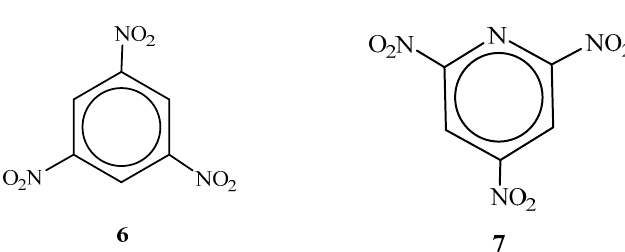
Table 4. Some experimental densities and heats of formation, Δ H f